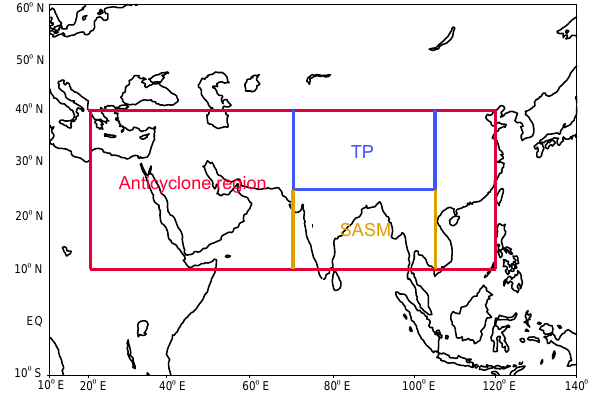
Figure 1. Regions examined in this study: the Tibetan Plateau re- gion (TP, 70–105 ◦ E, 25–40 ◦ N), the SASM region (SASM, 70– 105 ◦ E, 10–25 ◦ N), and the anticyclone region of (20–120 ◦ E, 10– 40 ◦